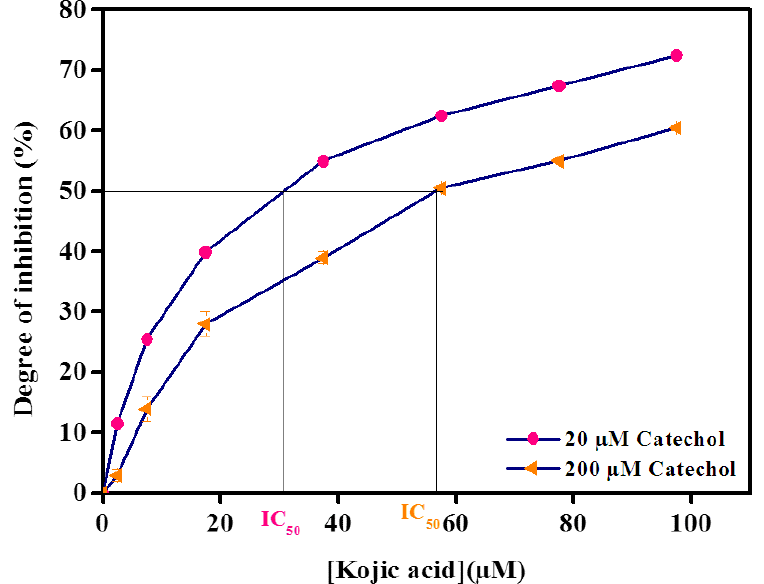
Figure 2. Competitive inhibition of tyrosinase immobilized on the carbon black paste by kojic acid in the presence of 20 µM and 200 µM catechol in 0.1 M phosphate buffer, pH 6.8. The applied potential is − 0.15 V vs. Ag/AgCl. Data are mean ± SD, n = 3.